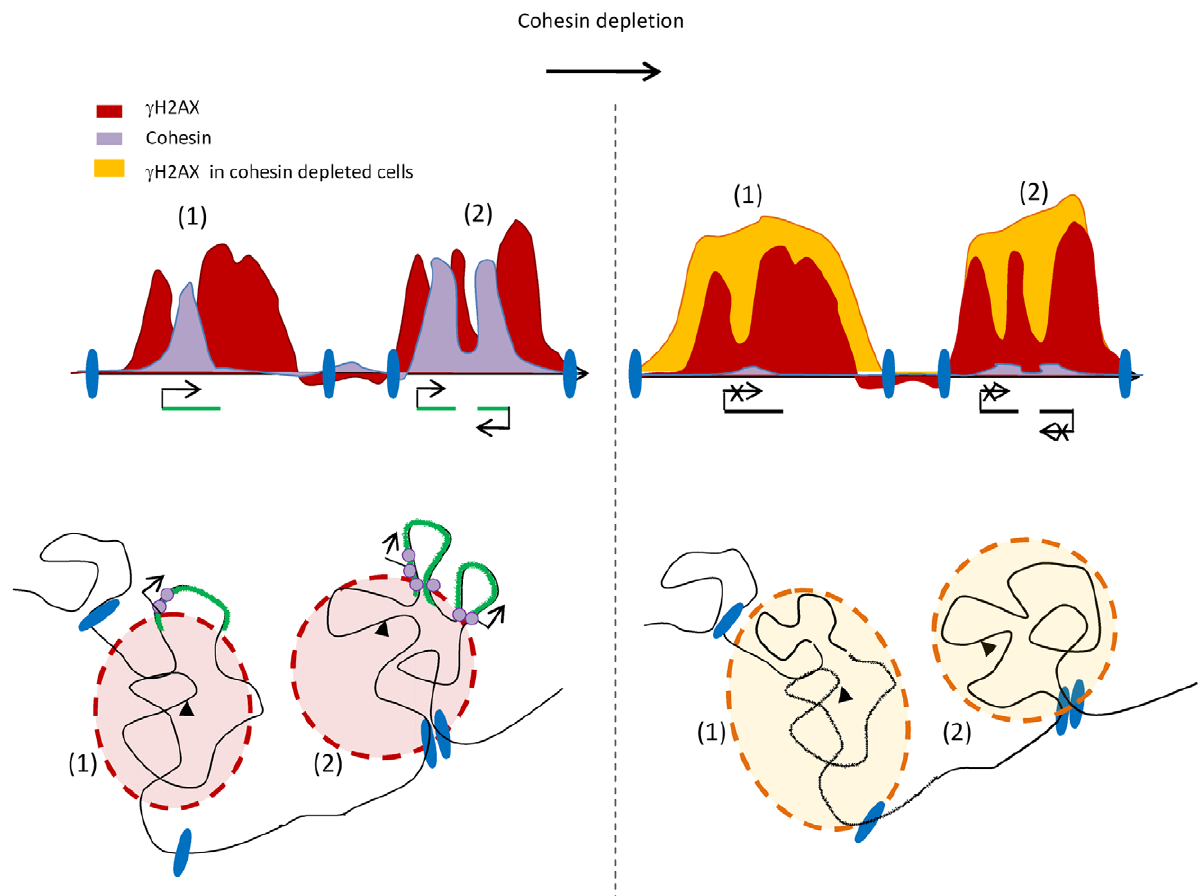
Figure 7. Model of 3D c H2AX spreading. Upon DSB induction (black triangle) c H2AX spreads within a nuclear space ( c H2AX foci in red). Some regions within c H2AX foci could be withdrawn to be, for example transcribed (green loop), therefore leading to ‘‘holes’’ within the c H2AX domain, when depicted linearly (upper panel). The cohesin normally present along the chromosomes in undamaged cells, (purple circle) may play a role after DSB induction, in keeping such genes outside of c H2AX foci due to their long range interaction properties. They could thereby protect genes from the surrounding chromatin changes and ensure their correct transcription. Upon cohesin depletion (right panel) these loops would reintegrate c H2AX foci leading both to the increase of c H2AX on genes and a decrease in transcription. In addition, c H2AX foci could be demarcated by large chromosomal domains, anchored via unknown components (blue ellipses). On some domains (1), the increase in c H2AX upon cohesin depletion would extend the limits of c H2AX until iteither fades awayorreaches a chromosomal domaintransition(blue ellipse). On other domains(2), cohesindepletion would not lead toan extension of c H2AX spreading, due to the pre-existence of a chromosomal domain transition at the boundary. These elements which define chromosomal domains transitions are unlikely to be cohesins since there is no correlation between c H2AX boundary position and cohesin